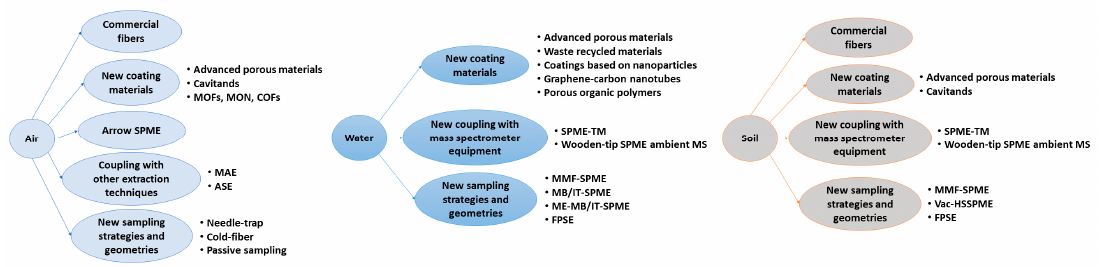
Figure 1. Main solid-phase microextraction—geometries and strategies used in the analysis of environmental matrices during the covered period (2014–2019).